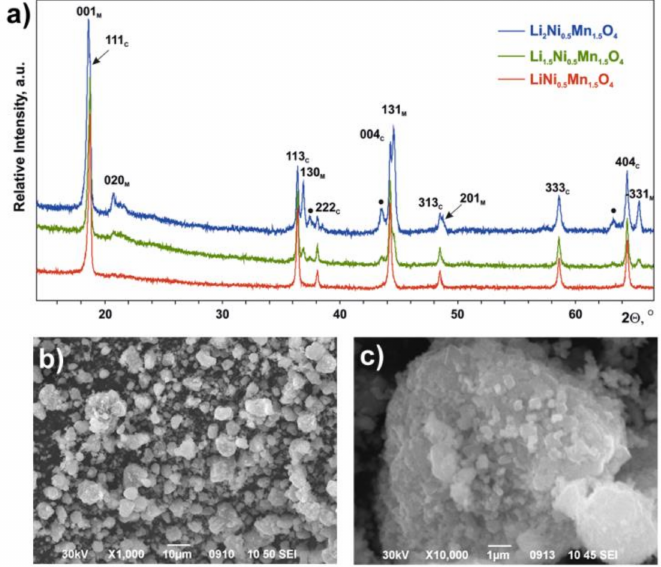
Figure 1. ( a ) Powder X-ray diffraction (PXRD) patterns of the initial samples. The reflections of cubic LiNi 0.5 Mn 1.5 O 4 (C) and monoclinic Li 1+ x M 1 − x O 2 (M) phase are indexed. The reflections of the Li z M 2 − z O 2 phase are marked by dots. ( b , c ) Scanning electron microscopy (SEM) images for the LiNi 0.5 Mn 1.5 O 4 sample.